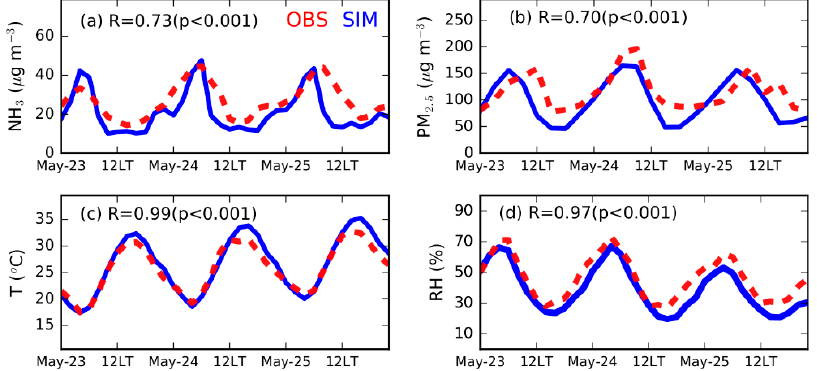
Figure 4. Time series of observed and simulated ( a ) NH 3 concentrations, ( b ) PM 2.5 concentrations, ( c ) 2-m Ts, and ( d ) 2-m RHs in Beijing from 23 to 25 May, 2015. The correlation coefficients (R) between observations and simulations are presented for each panel.